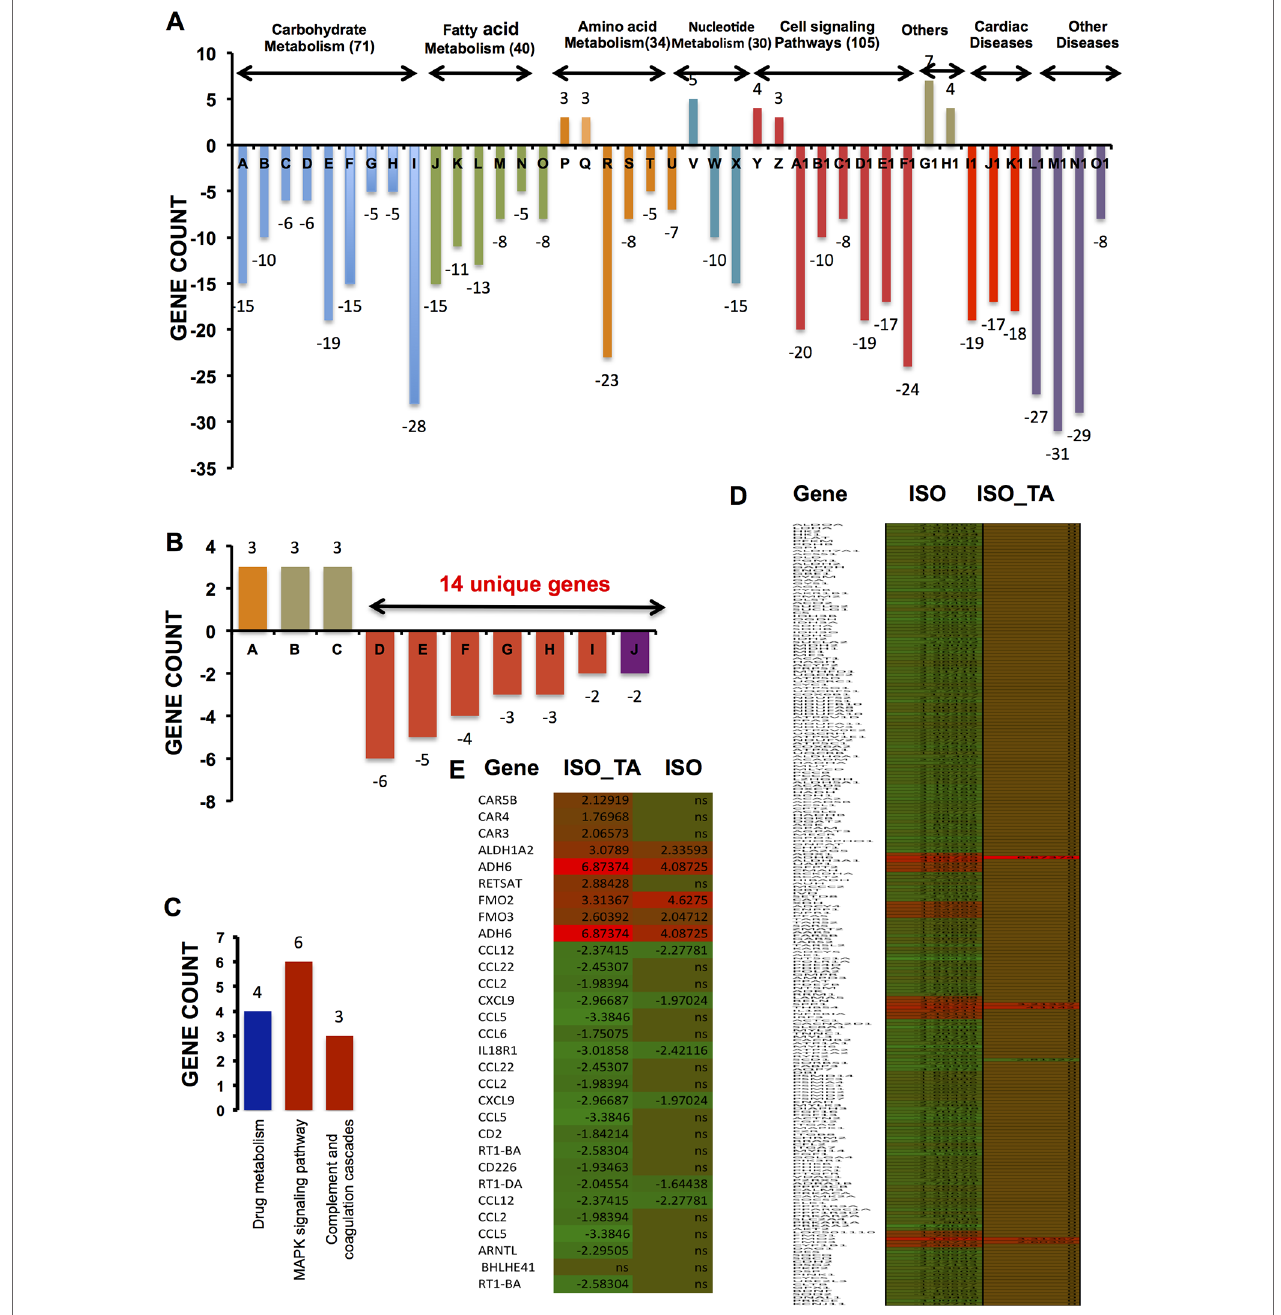
FIgURE 2 | KEGG pathways significantly enriched after multiple testing adjustments ( p < 0.1) (A) Bar graph indicates KEGG pathway upregulated and downregulated after ISO treatment. Pathways under the same group (carbohydrate metabolism, fatty acid metabolism, etc.) are clustered together and marked by the same color. The number of unique genes modulated in each group are shown in parenthesis next to the respective group names. The total number of genes modulated in various pathways under each group is generally larger than the total number of unique genes mentioned in parenthesis. It is due to the occurrence of same genes in multiple pathways and accordingly, those were counted more than once. The individual pathways given in the bar graph (A-O1) is tabulated in Table 1 . (B) Bar graph representing genes upregulated and downregulated by ISO + TA is shown. The total number of unique genes that were downregulated is 14. The total number of genes modulated in various pathways under each group is more than 14 as the same genes might be associated with multiple pathways, hence counted more than once. (C) Bar graph representing three different pathways involving 13 unique genes upregulated by TA alone is shown. The individual pathways given in the bar graphs in A and B is tabulated in Table 1 . (D) Heatmap of significantly regulated genes in the ISO group compared to ISO_TA group along with expression value. (E) Heatmap of significantly regulated genes in the ISO _TA group compared to ISO group along with expression value. The genes, which are not significantly regulated, are indicated as ns (non-significant). A detail of expression value of heatmap along with p-value is tabulated in supplementary Table s5 .